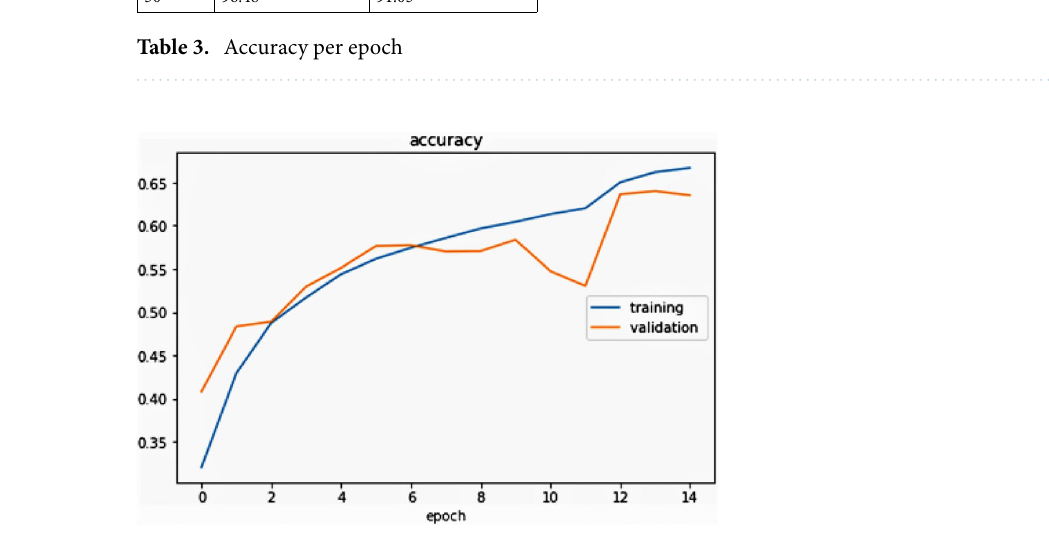
Figure 15. Graphical view of training and validation accuracy per